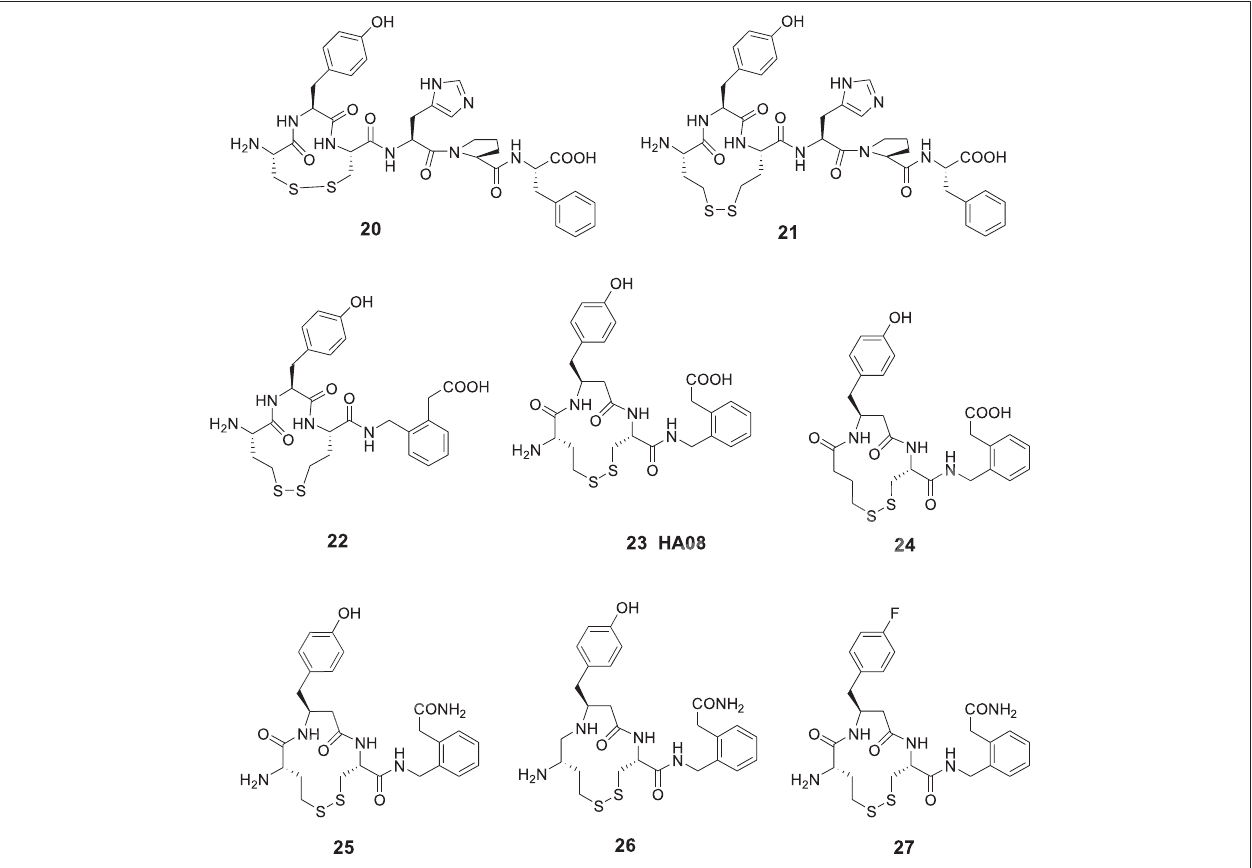
Figure 6 | Macrocyclizations in the N-terminal. The Ang IV analogue 20 encompassing an 11-membered macrocycle is inactive while 21 with a 13-membered ring systeminhibitsIRAPef fi ciently.Theselectivecompound 23 (HA08)isthemostpotentIRAPinhibitorintheseriesanddeletionoftheN-terminalaminogroupof 23 makes the ligand ( 24 ) inactive. The carboxamide 25 is two-fold and the fl uoro compound 27 is 10-fold less potent than 23 as IRAP inhibitors. Compound 26 comprising a reduced peptide bond in the N-terminal is a weak IRAP inhibitor.